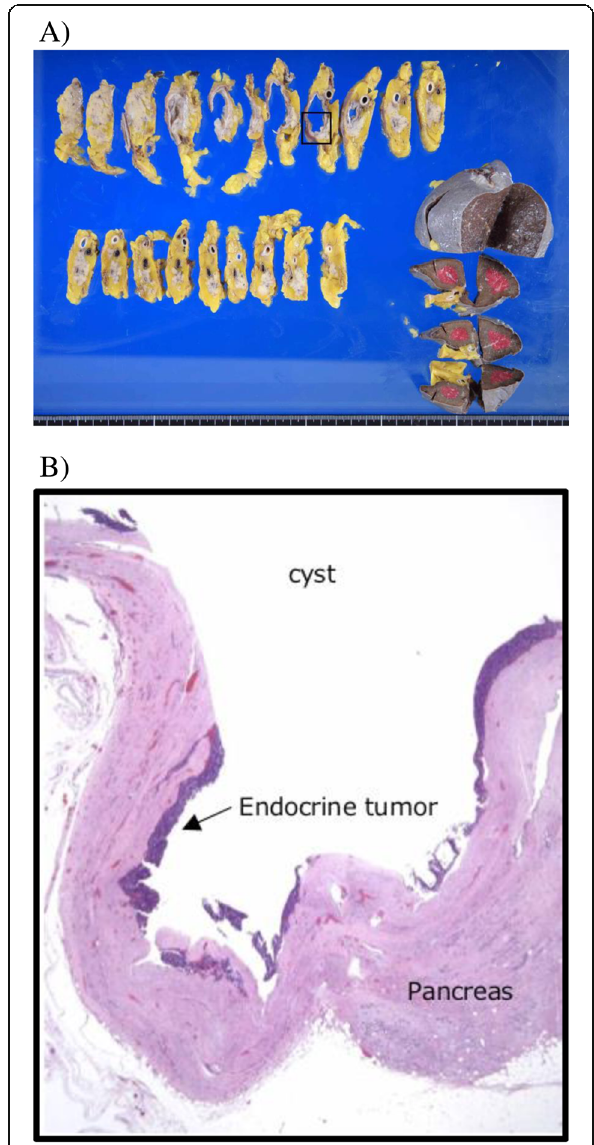
Fig. 5 a Macroscopic findings demonstrated a cystic lesion measuring 21 × 11mm in the tail of the pancreas. b Histopathology revealed that the wall of the cyst was filled with fibrous connective tissue, with some growth of tumor cells consisting of atypical cells with dense chromosomes on the inner surface (hematoxylin and eosin